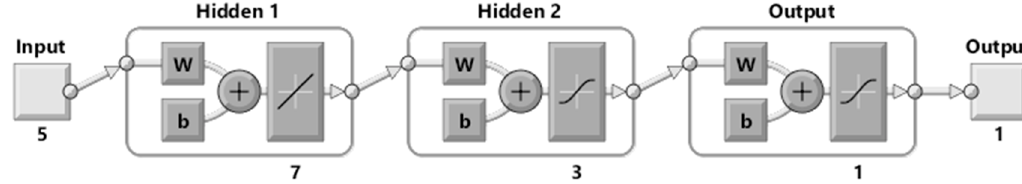
Figure 3. Schematic of the implemented neural network in MATLAB.